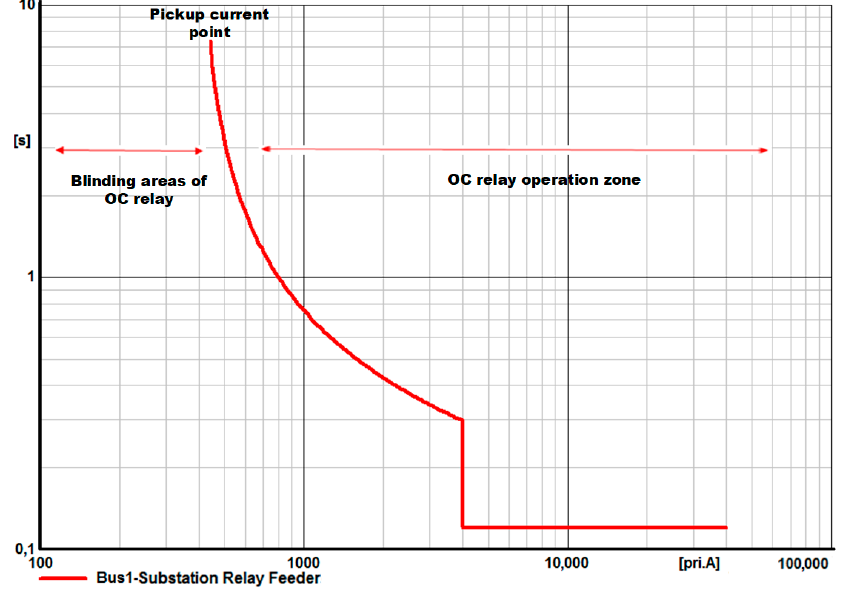
Figure 5. Characteristic curve of the overcurrent (OC) relay operation zone and blinding zones.